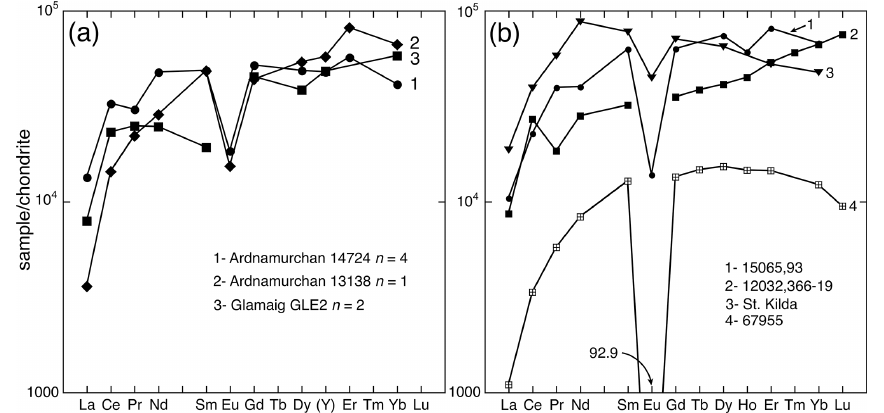
Figure 12. (a) Chondrite-normalized plot of zirconolite from Ardnamurchan (samples 14724, 13138) and Glamaig (sample GLE2). Yttrium plotted for Ho. (b) Chondrite-normalized plot of zirconolite from 15065,93 Apollo 15 basalt (Wark et al., 1973), 12032,366-19 Apollo 12 granite (Seddio et al., 2011), St. Kilda pegmatite (Fowler and Williams, 1986), and 67955 Apollo 16 melt rock (Norman and Nemchin, 2014). The normalized Eu value for 67955 is given but not plotted. Normalizing factors from McDonough and Sun (1995).